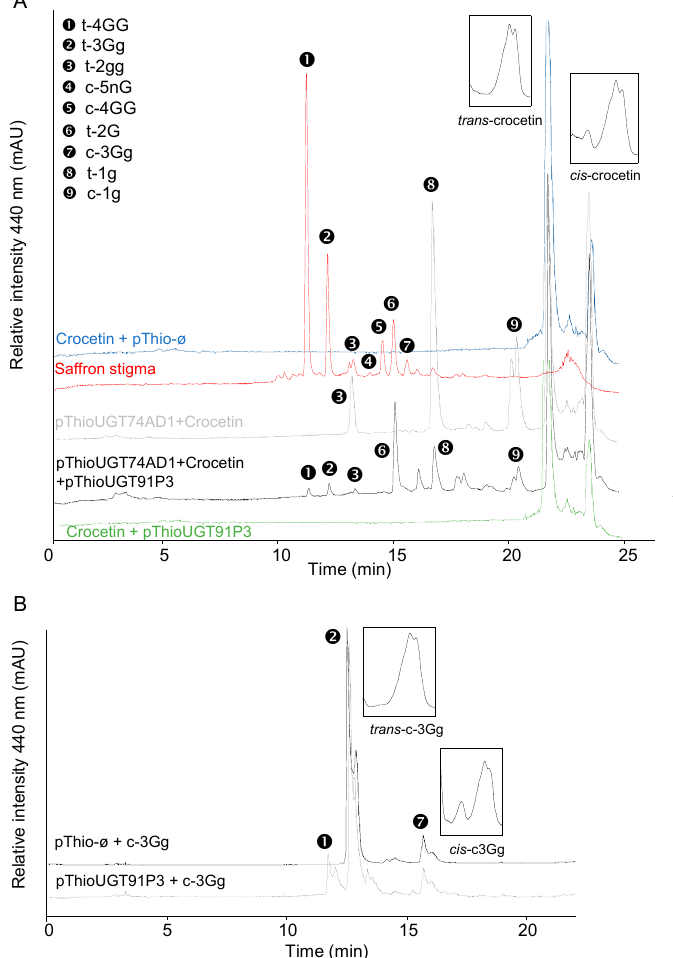
Figure 4. Enzyme activity of UGT91P3. The UGTs were expressed in E. coli and protein extracts were assayed for activity with crocetin and crocins. ( A ) Enzyme assays using crocetin as substrate. ( B ) Enzyme assays using crocin t-3Gg as substrate. As controls, all the assays were performed with protein extracts from E. coli transformed with an empty vector. Products were analyzed using HPLC-DAD and HESI-HRMS. UV detection was monitored at 440